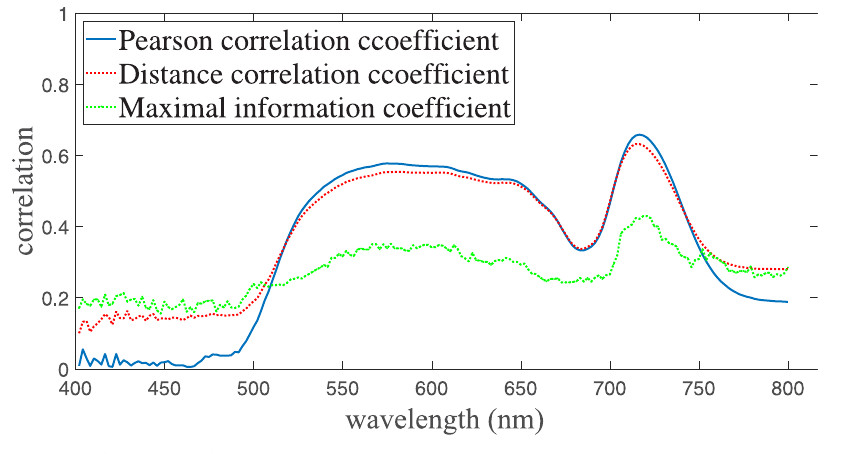
Fig 5. Single band correlation analysis